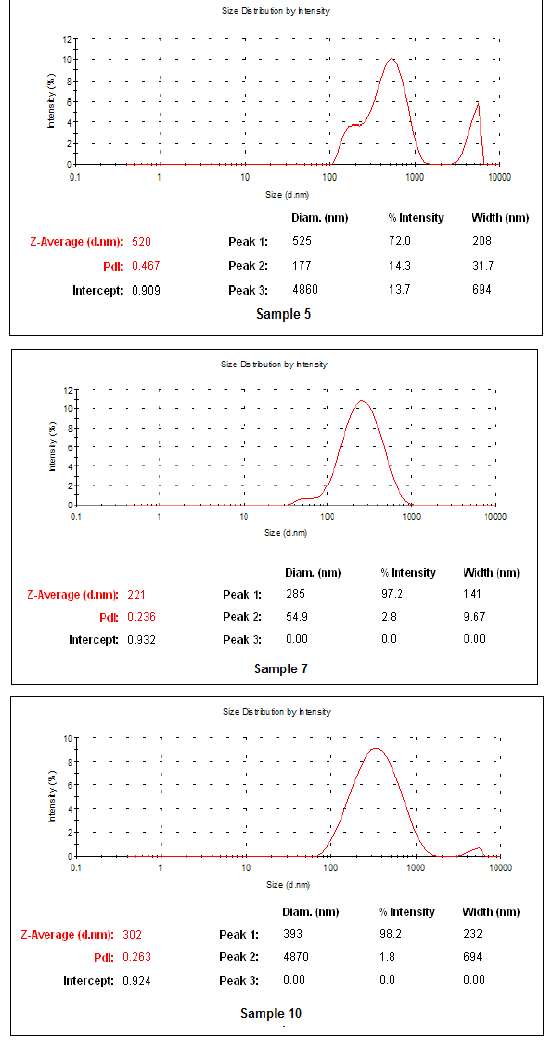
Figure 2. Results of DLS analysis for selected PDMS particles